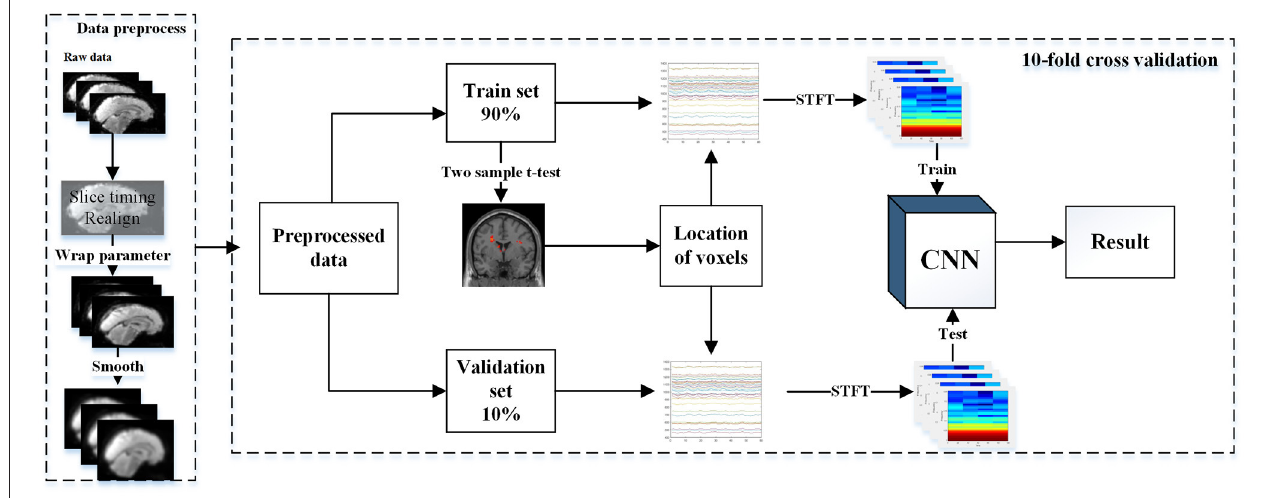
FIGURE 1 | Model training and a 10-fold